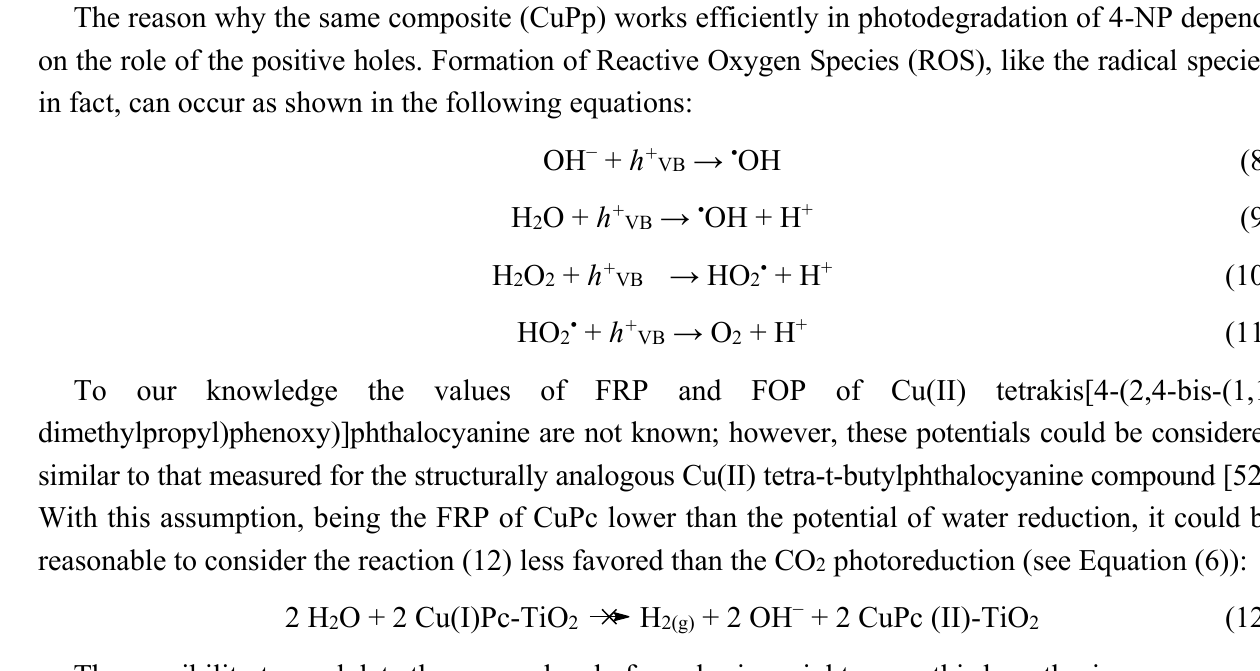
Figure 5. Representation of energy level of TiO 2 , CuPp, CuPc and H 2 O/H 2 vs.